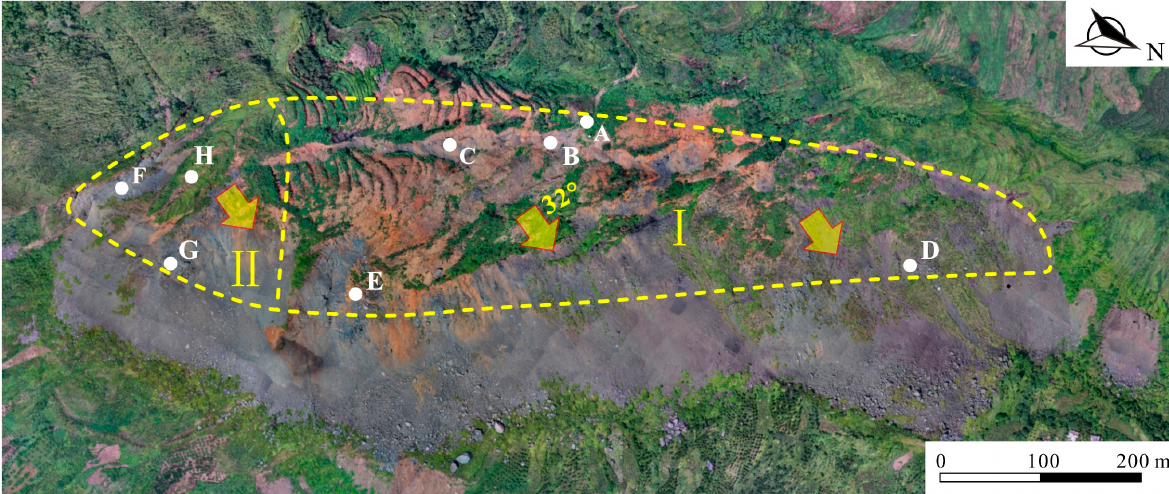
Figure 8. Division of the landslide deformation area (taken by UAV). Zone I and zone II represent two deformation zones. The marked points A–H are the locations of typical deformation areas, and the specific deformation characteristics can be referred to Figures 12 and 13.